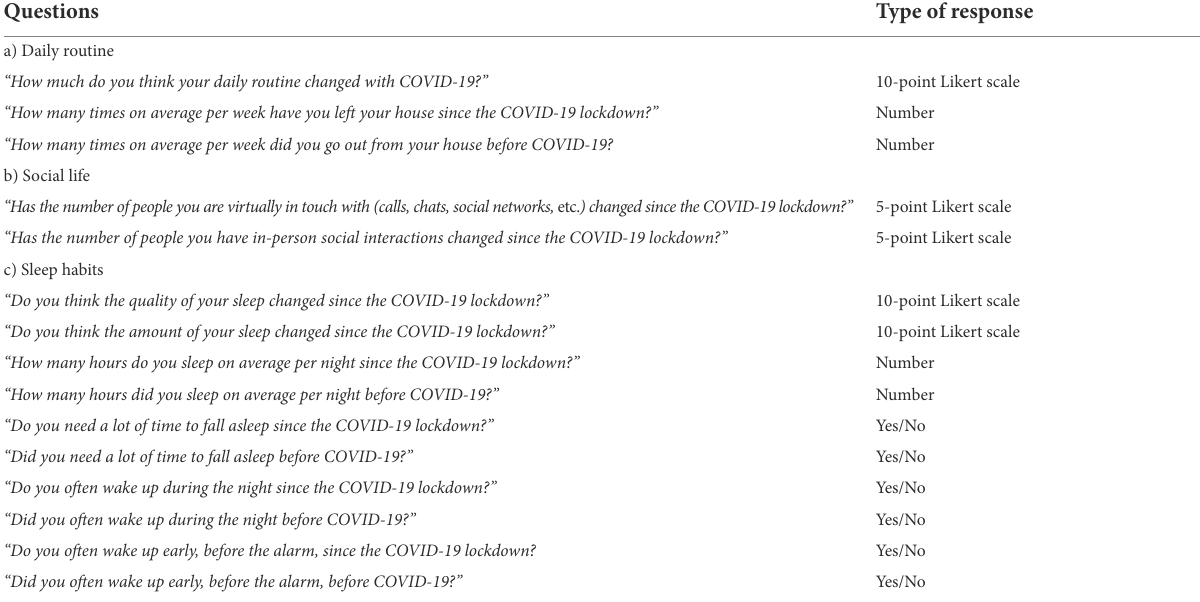
TABLE 2 Questionnaire 1 questions list: items were divided into three main categories: daily routine, social life, and sleep habits.